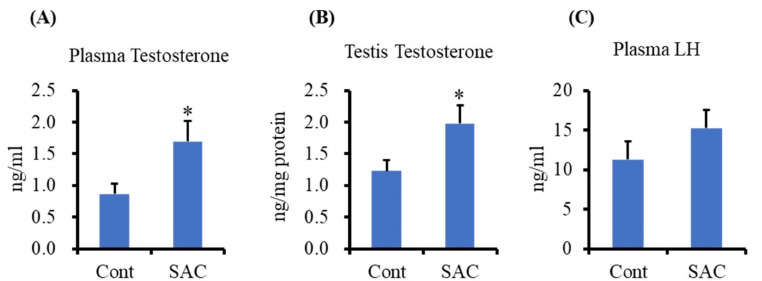
Figure 2. S -allyl cysteine (SAC) enhances testosterone production in mice. BALB/c mice were administered SAC at 50 mg/kg body weight intraperitoneally for 6 h. Testosterone level in ( A ) plasma ( n = 6–7) and ( B ) testis ( n = 7–8) was measured by enzyme immunoassay (EIA). ( C ) Plasma luteinizing hormone (LH) was measured in plasma by ELISA ( n = 6). Data are presented as the mean ± standard error (SE). Data were analyzed by Student’s t -test. * p < 0.05 compared to the control group.